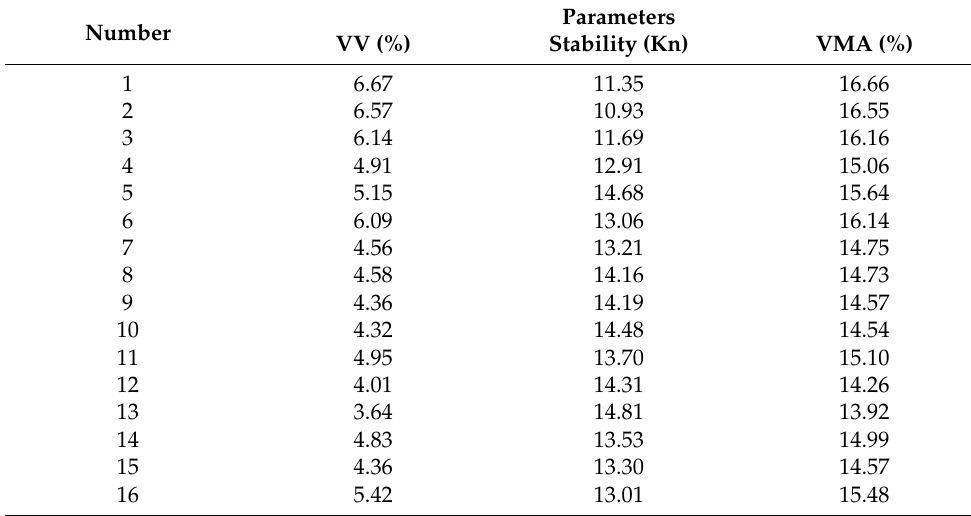
Table 13. Orthogonal test results.